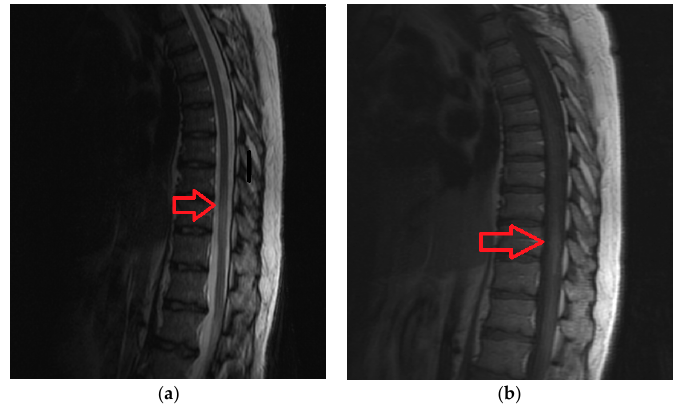
Figure 3. ( a ) Magnetic Resonance Imaging shows a hyperintense signal on T2 ‐ SAG ‐ FRFSE (T2 ‐ weighted Sagital Fast Recovery Fast Spin Echo) sequence at T8 ‐ T10 levels. ( b ) Magnetic